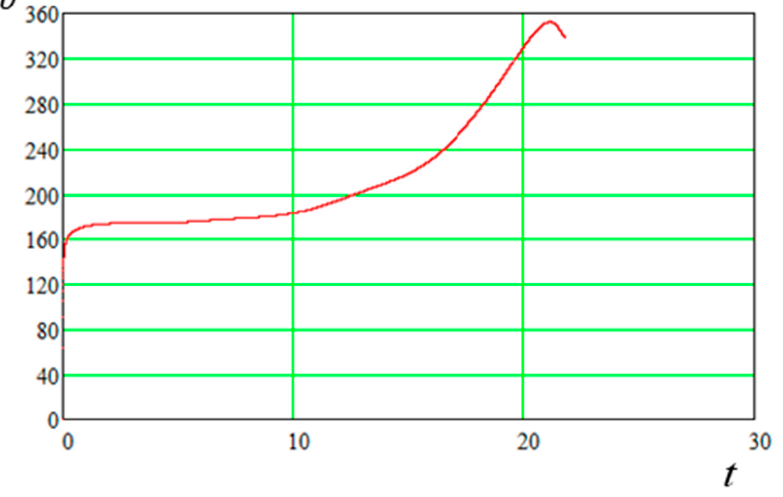
Figure 11. Osculating argument for the perigee of a transfer orbit as a function of flight time [un- dim.].